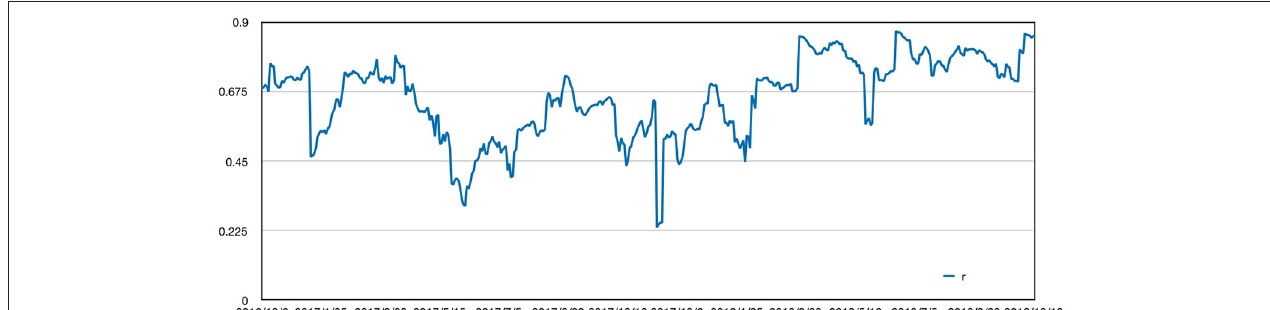
FIGURE 7 | Dynamic condition correlations.